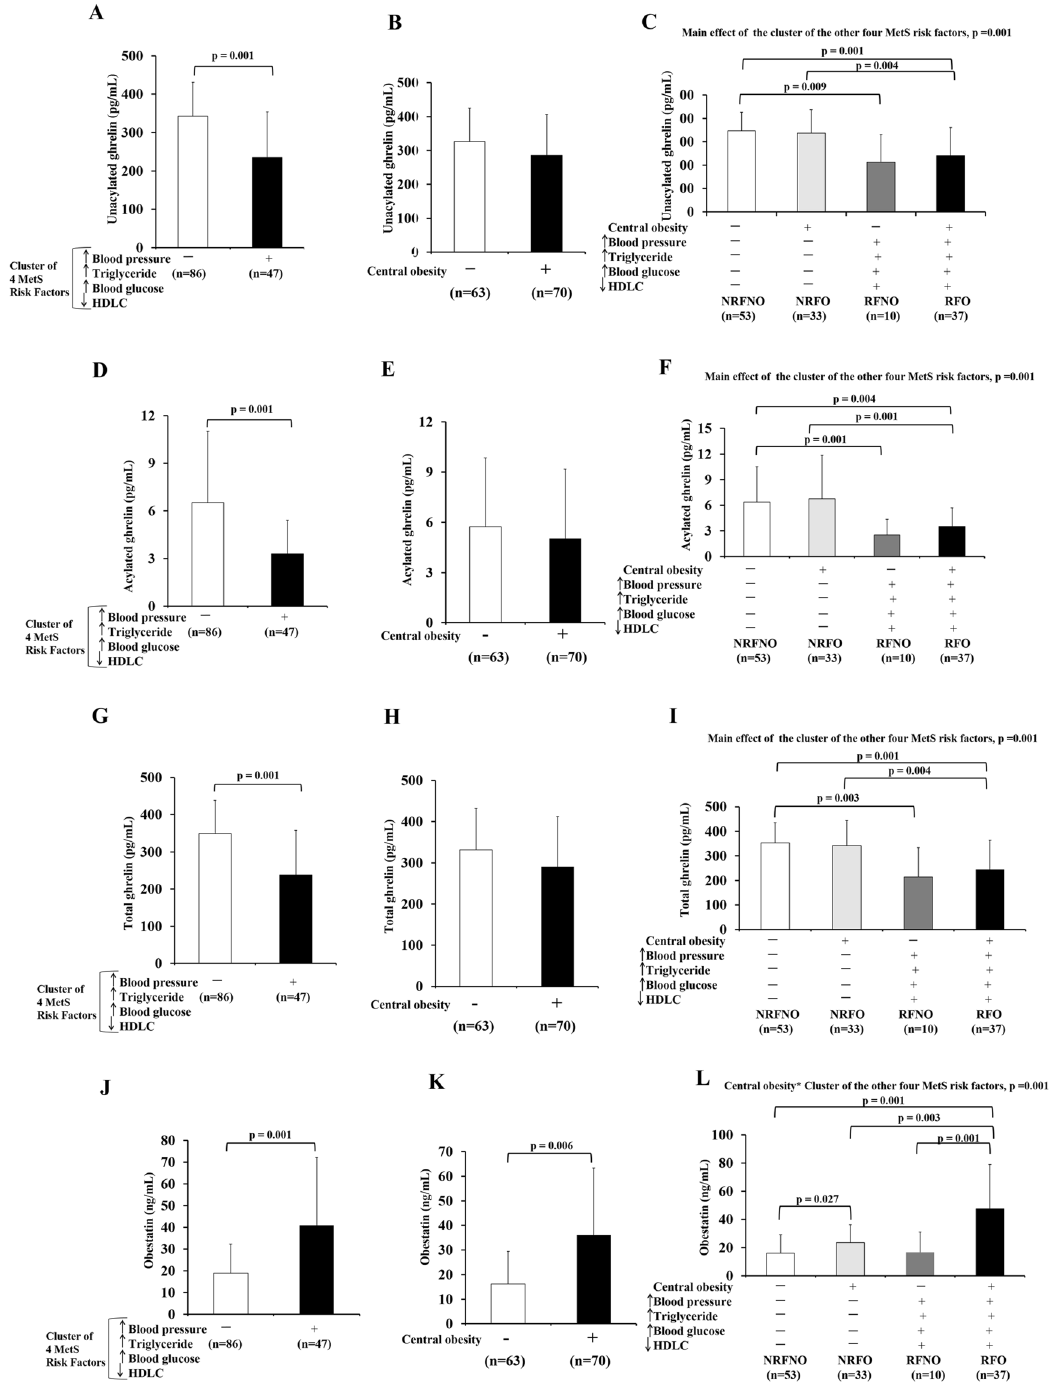
Figure 1. Levels of ghrelin gene products in response to CO or the cluster of the other four MetS risk factors alone as well as CO in conjunction with the cluster of the other four MetS risk factors. Unacylated ghrelin, acylated ghrelin and total ghrelin levels of subjects with/without the cluster of four MetS risk factors regardless of the status of CO (RFNO and RFO vs NRFNO and NRFO) ( A,D,G ). Unacylated ghrelin, acylated ghrelin and total ghrelin levels of subjects with/without CO regardless of the status of the cluster of four MetS risk factors (NRFNO and RFNO vs NRFO and RFO) ( B,E,H ). Comparison of unacylated ghrelin, acylated ghrelin and total ghrelin levels among subjects with no MetS risk factors, central obese only, the cluster of the other MetS risk factors other than central obese, and all MetS risk factors ( C,F,I ). Obestatin levels of subjects with/without the cluster of four MetS risk factors regardless of the status of CO (RFNO and RFO vs NRFNO and NRFO) ( J ). Obestatin levels of subjects with/without CO regardless of the status of the cluster of four MetS risk factors (NRFNO and RFNO vs NRFO and RFO) ( K ). Comparison of obestatin among subjects with no MetS risk factors (NRFNO), central obese only (NRFO), the cluster of the other MetS risk factors other than central obese (RFNO), and all MetS risk factors (RFO) ( L